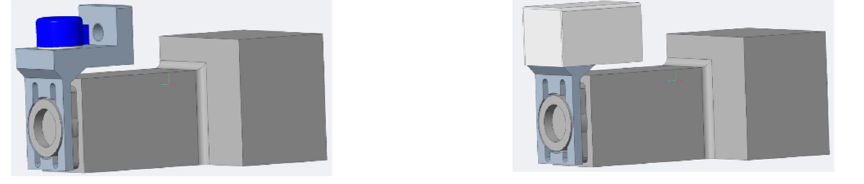
Figure 3. CAD layout of the sensor integration (sensor in blue on the left, sensor with protecting housing on the right).